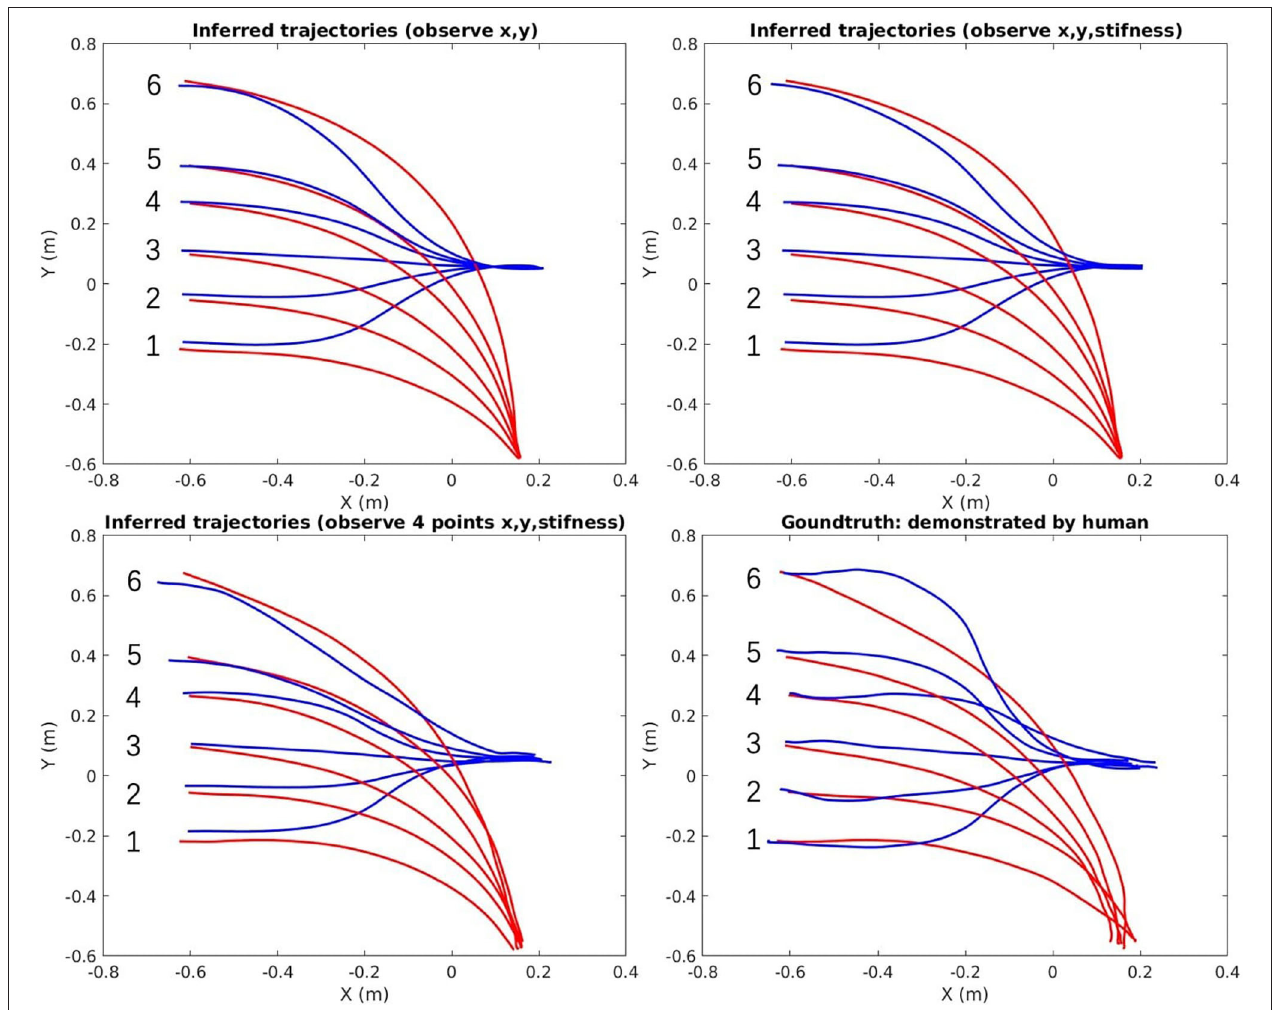
FIGURE 10 | The inferred trajectories vs. the ground truth of the hand-over task [red (human arm)/blue (robot)].